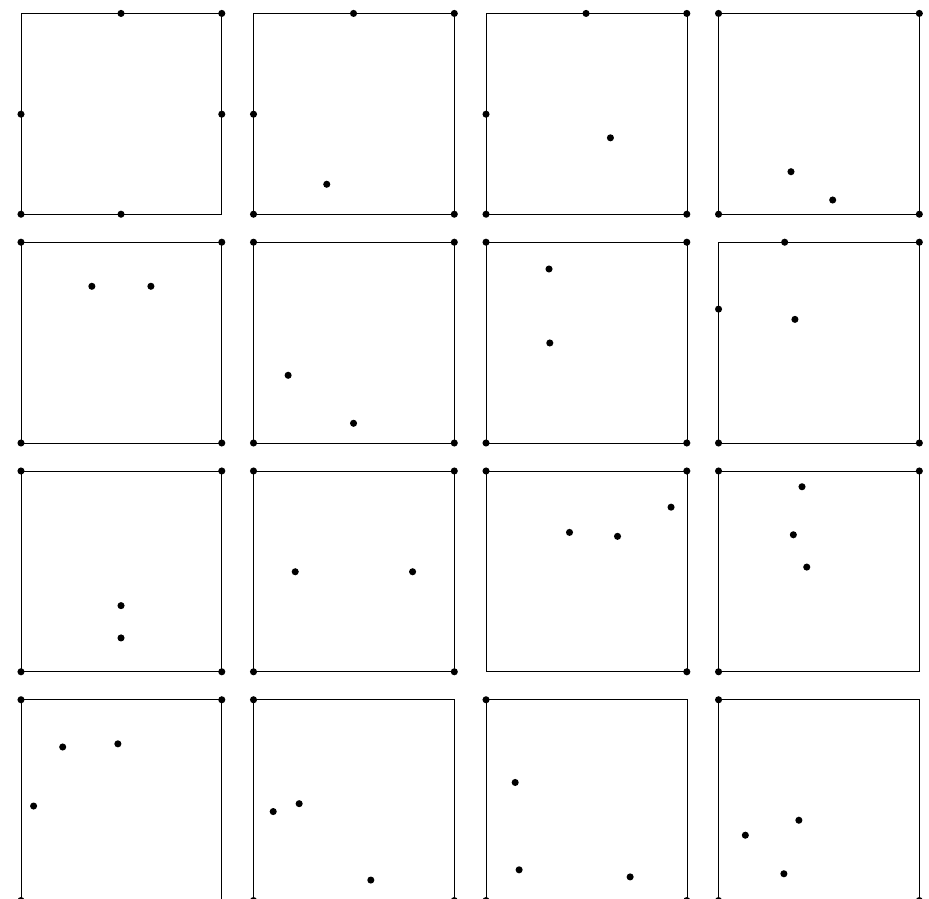
Figure 4. The 16 optimized subsets in C 6